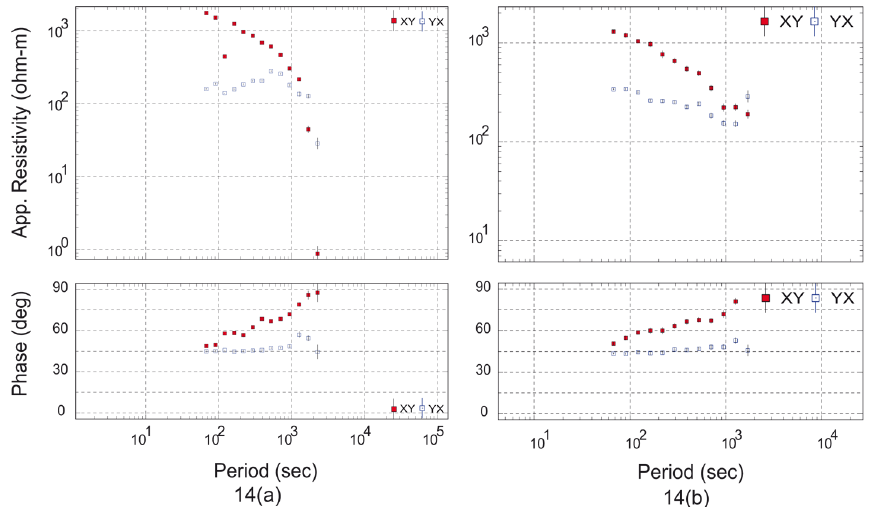
Figure 14. Effect of FFT length on a small culturally affected noisy data set of 16S sampling frequency of site K11 with 19,303 dada points. (a) Apparent resistivity (upper panel) and phase (lower panel) curves obtained from the data using a FFT length of 1024. (b) Apparent resis- tivity (top panel) and phase (bottom panel) curves obtained applying a FFT length of 512 on the same data set provides a better outcome as this FFT length can give optimal number of stacks for this small disturbed data set. The red colored boxes represent XY components and the blue colored boxes represent YX components of apparent resistivity and